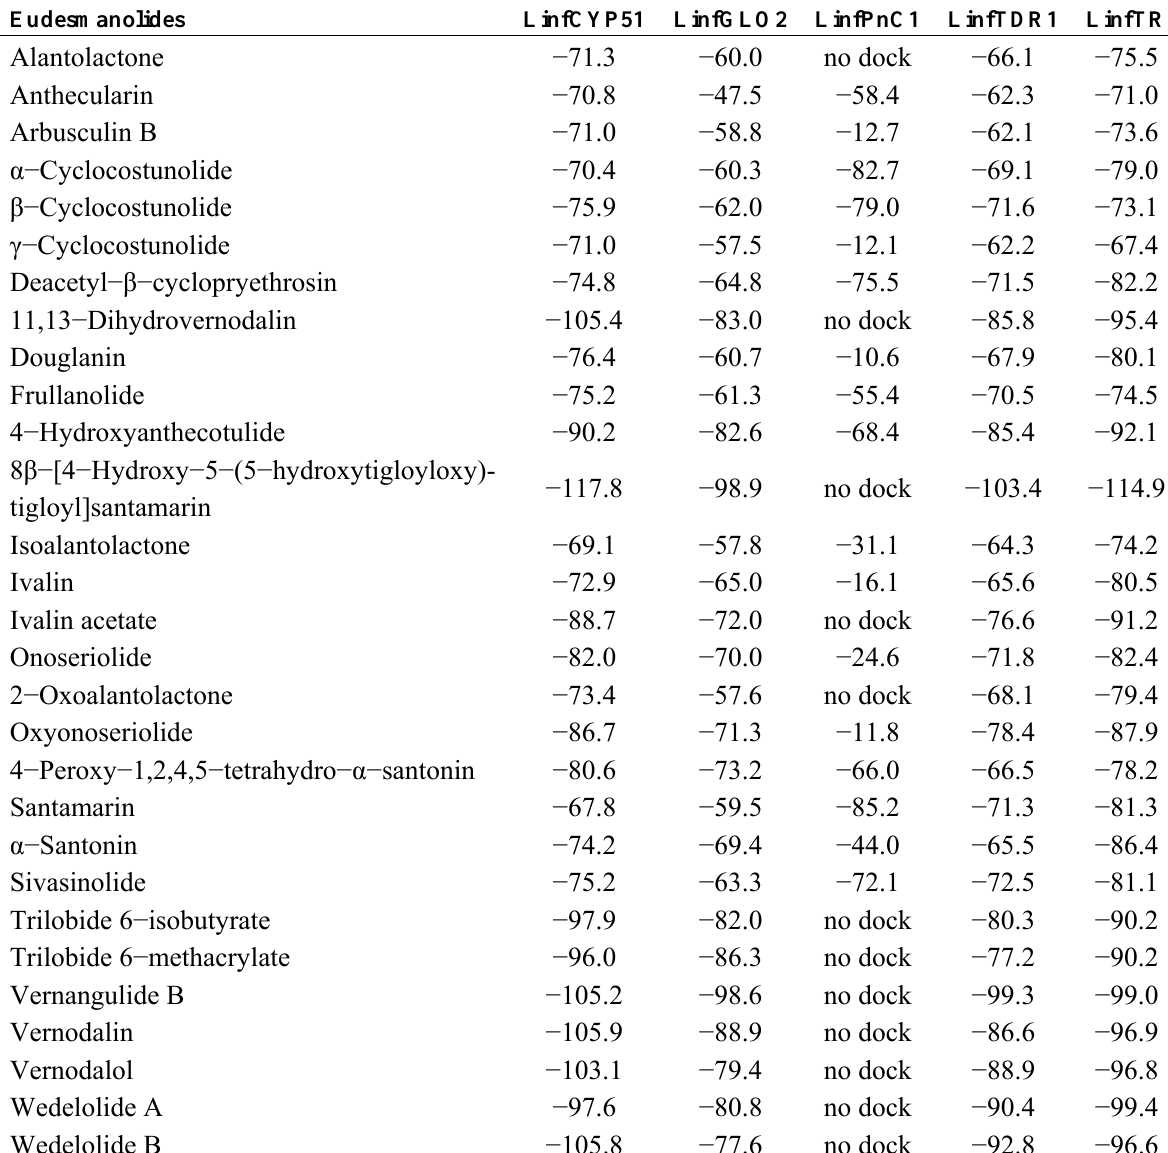
Table 12. MolDock docking energies (kJ/mol) of eudesmanolide sesquiterpenoids with Leishmania infantum protein